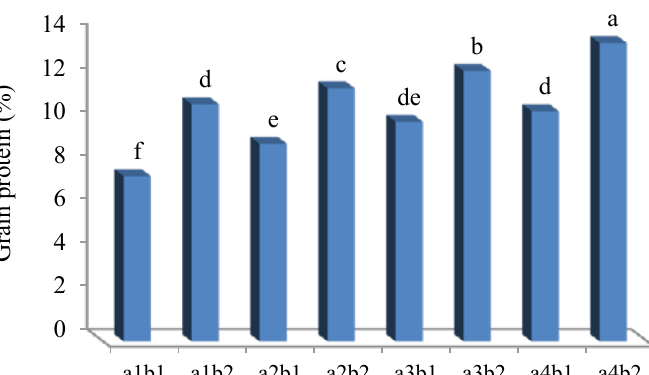
Figure 2. Effect of soil type (b1: non-contaminated and b2: contaminated soil) and zeolite treatments (a1: zero, a2: 0.5%, b3:1.5%,